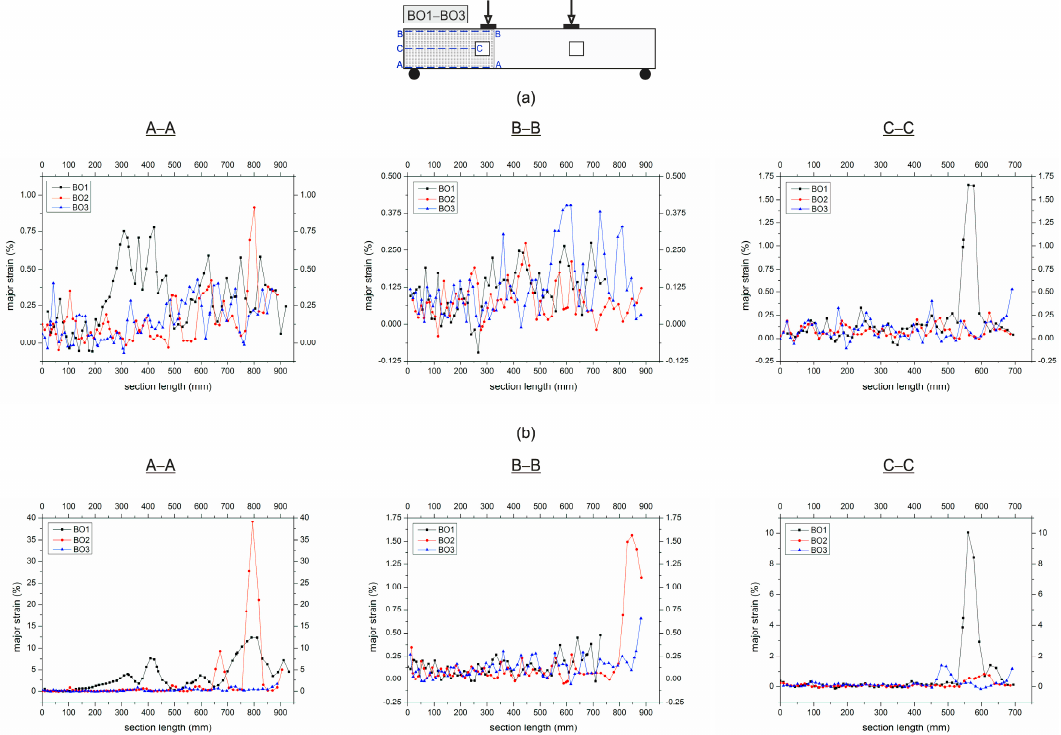
Figure 12. Major strains of concrete beam (BO1) and hybrid fibre concrete beams (BO2, BO3) with openings: ( a ) at service load, and ( b ) at maximum load.